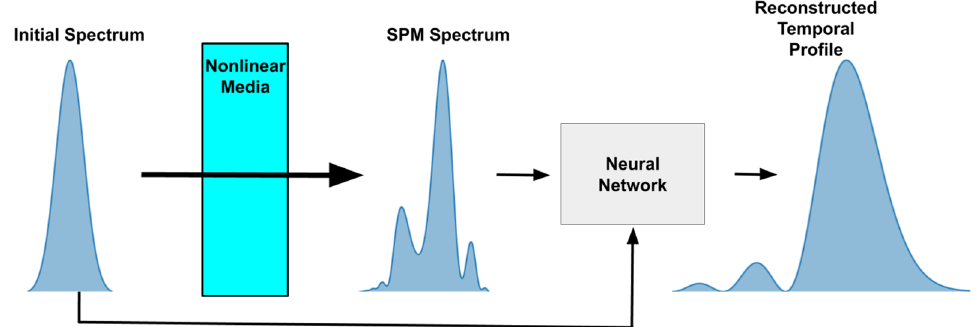
Figure 1. Example setup for using self-phase modulation to measure the initial temporal profile of a pulse. The initial spectrum passes through a material with a Kerr nonlinearity, causing a change in the spectrum due to self-phase modulation. A neural network takes the initial and final spectrum as inputs and extracts the initial phase and fluence of the initial pulse, allowing the initial temporal profile to be